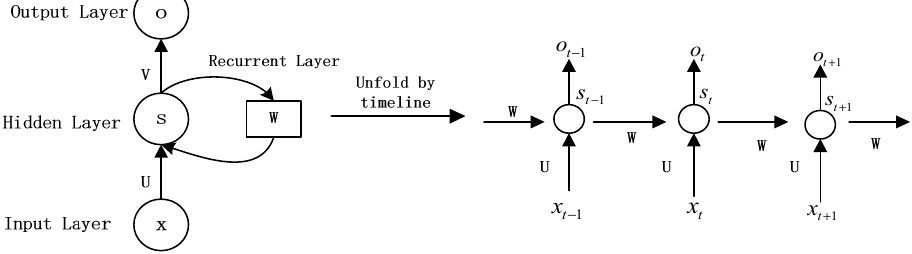
Figure 1. Recurrent neural network